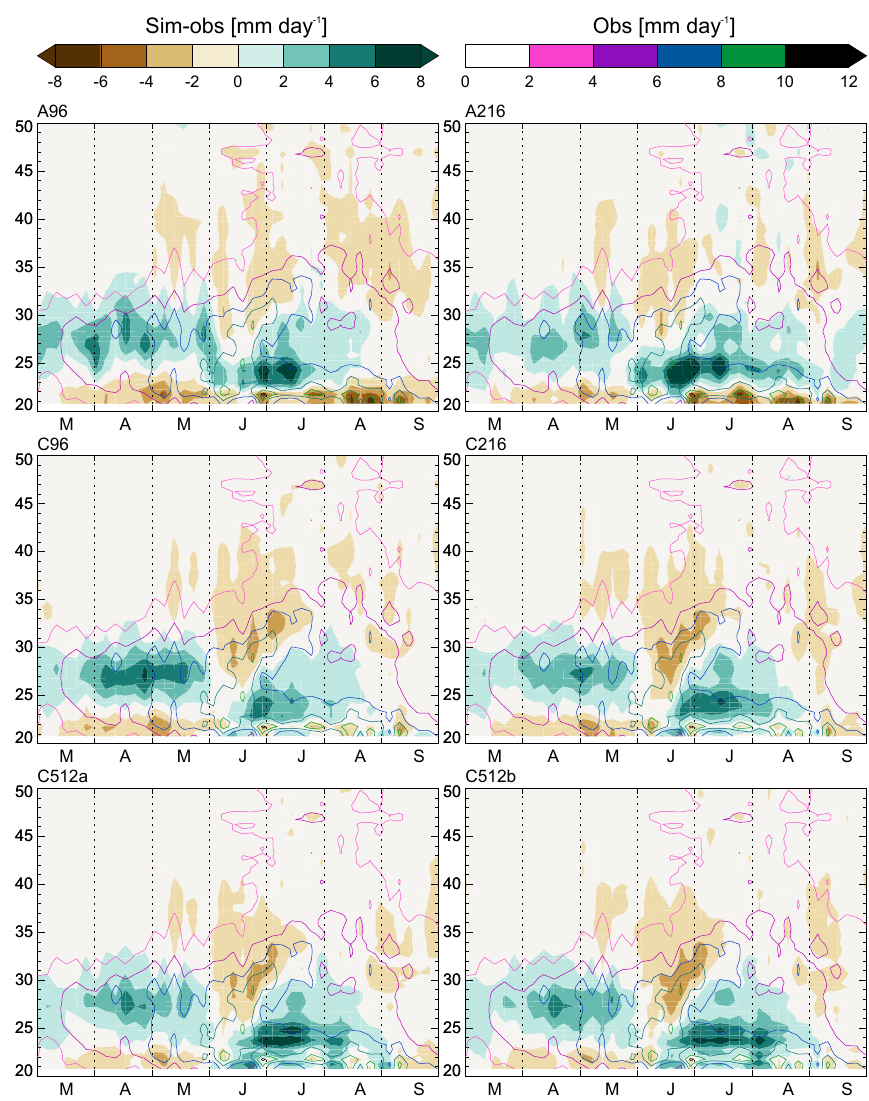
Figure 3. Hovmöller diagram showing the difference between simulated and observed May–September precipitation (shading), and observed precipitation (contours) averaged over 105–120 ◦ E as a function of pentad ( x axis) and latitude ( y axis), using the period 1982–2007 for observations and the full length of each simulation. All data are interpolated to the APHRODITE